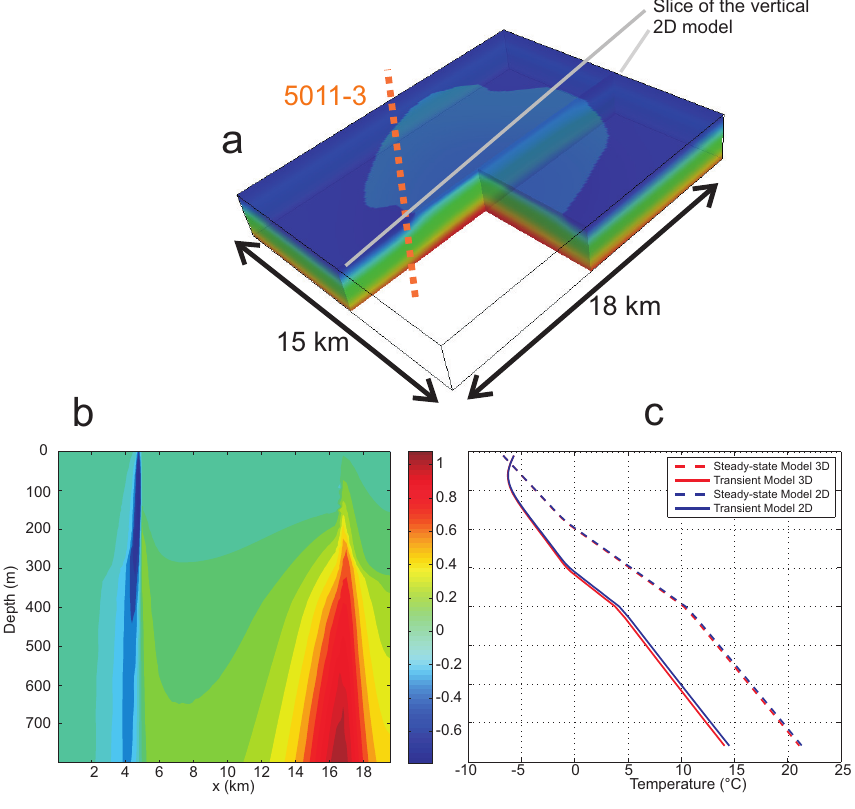
Fig. 12. Comparison of temperatures derived from simplified 3-D and 2-D models for the lake area. (a) Simplified 3D model for Lake El’gygytgyn and its surroundings, based on a quasi-realistic representation of the lake in its horizontal extension, but with a constant depth of 170m. Also shown is the position of the vertical slice chosen for the 2-D model, and the 5011-3 borehole. (b) Temperature differences (K) between a vertical slice through the full 3-D model, and the corresponding 2-D model. (c) Modeled borehole temperature profiles at the 5011-3